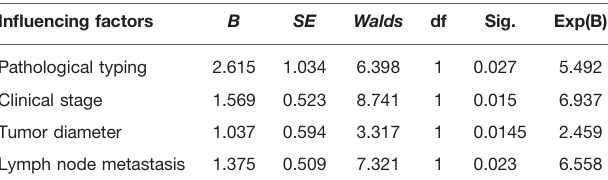
TABLE 5 | Multivariate analysis of prognosis of patients with medium-term and advanced cervical